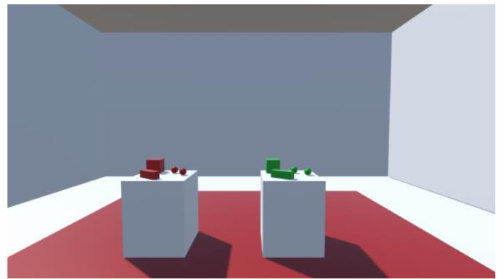
Figure 3. A neutral room for training and preparation of the participants. The red objects can be manipulated but cannot be bought, and the green objects can be manipulated and